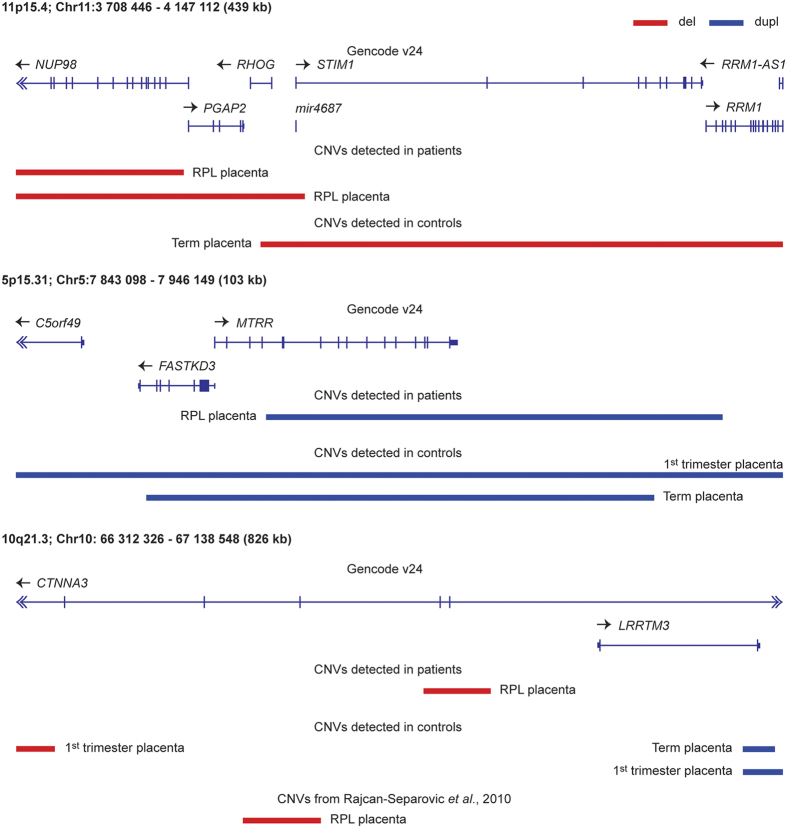
Genomic context of three alternatively rearranged regions in the pregnancy loss (RPL) compared to normal 1st trimester and term pregnancy placentas.Blue bars indicate duplication (dupl) and red bars deletion (del) CNVs.